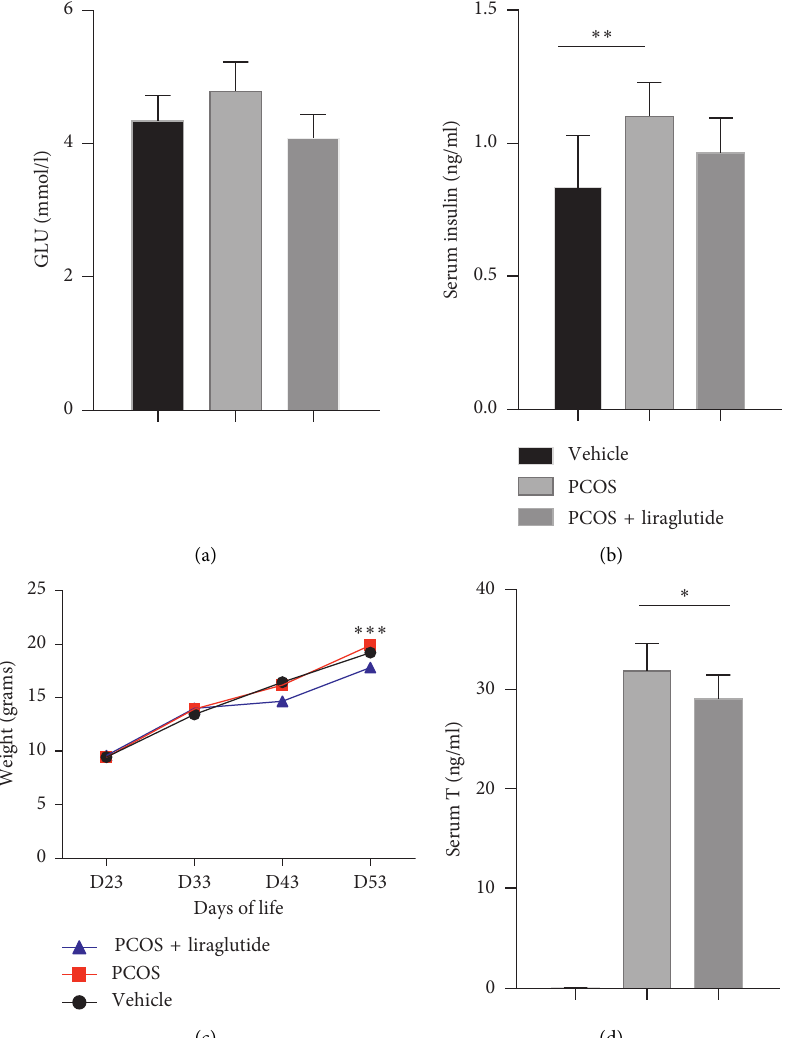
Figure 1: Serological and metabolic features were altered with or without treatment of liraglutide in PCOS model mice compared with vehicle group. The fasting blood glucose (a), serum insulin level (b), and blood testosterone level (c) were measured in serum samples collected from the three groups, PCOS +liraglutide, PCOS, and vehicle on D54 of life. The body weight was measured on D23, D33, D43, and D53 of life (d). The data were expressed as mean ± SEM ( N � 10 mice/one group). ∗ P < 0 . 05, ∗∗ P < 0 . 01, and ∗∗∗ P < 0 .